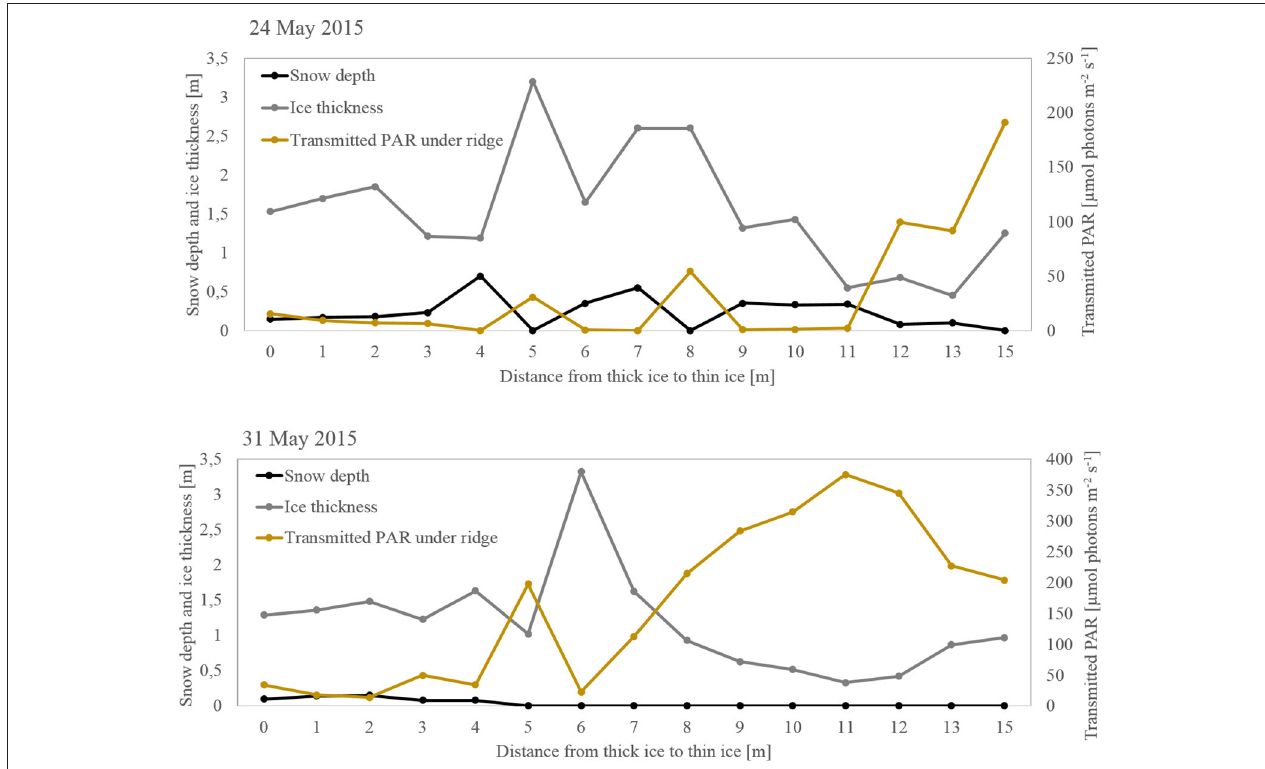
FIGURE 4 | Transect of light transmitted through the FYI ridge from the thick ice to the thin-ice side. Snow depth (black), total sea ice thickness (gray), and the estimated light transmitted below the ridge (yellow).